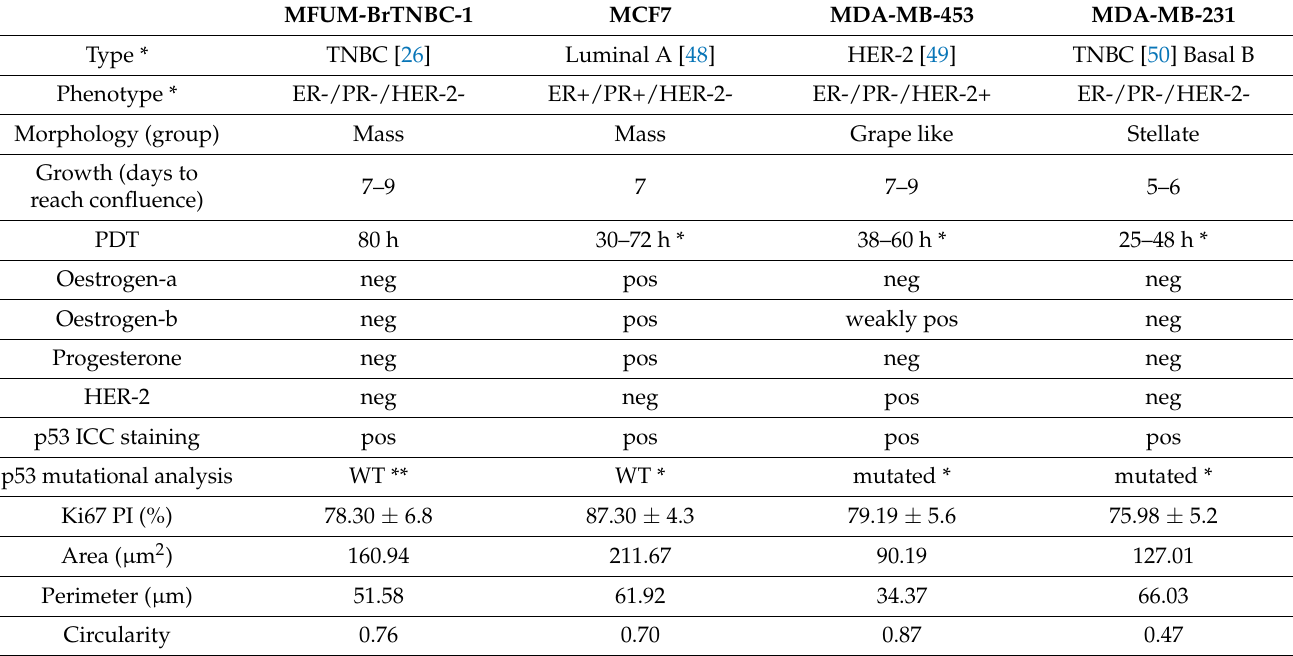
Table 1. Cell line